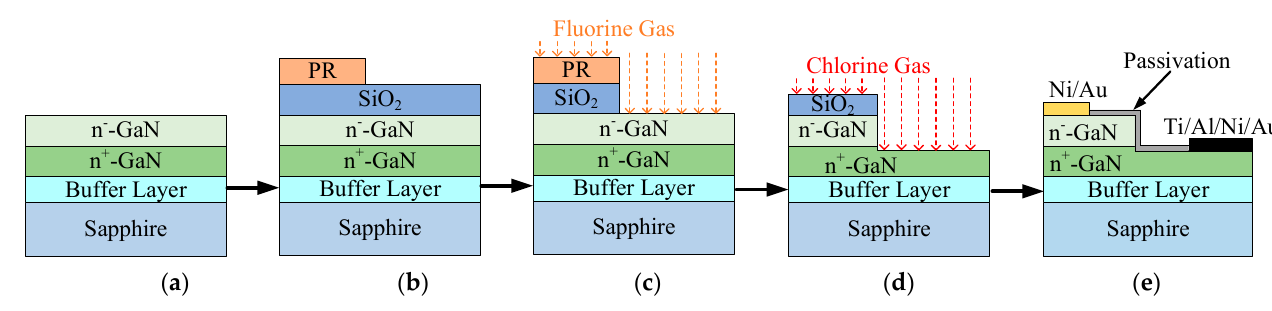
Figure 2. Simplified fabrication steps of the vertical GaN SBD. ( a ) Epitaxy structure of vertical GaN SBD on sapphire substrate; ( b ) photoresist (PR) and SiO 2 mask on GaN; ( c ) fluorine-based hard mask etching; ( d ) chlorine-based mesa etching; ( e ) electrode deposition and SiO 2 passivation.